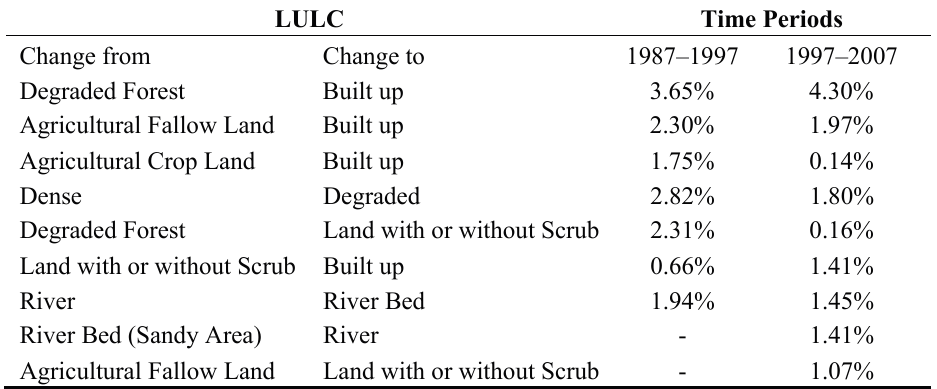
Table 14. Substantial exchanges/prominent transitions between LULC